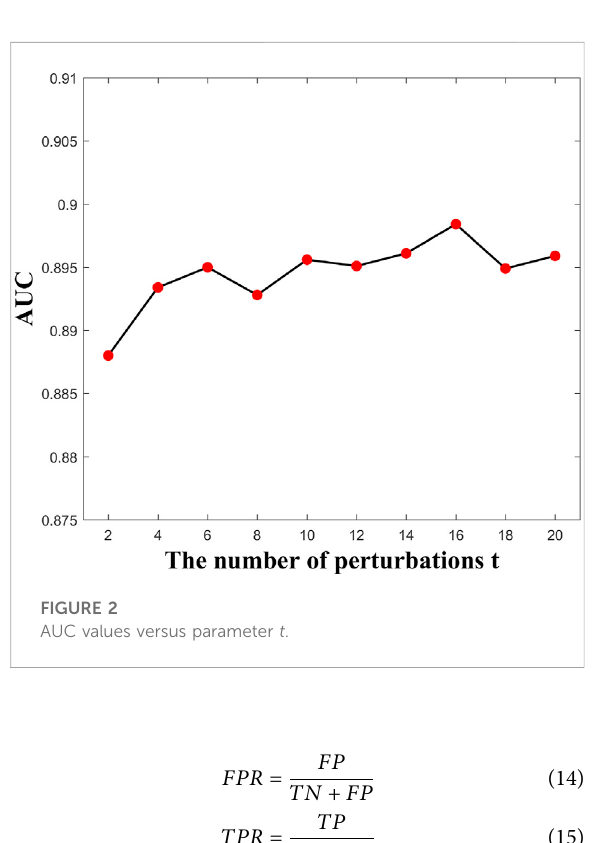
FIGURE 2 AUC values versus parameter t